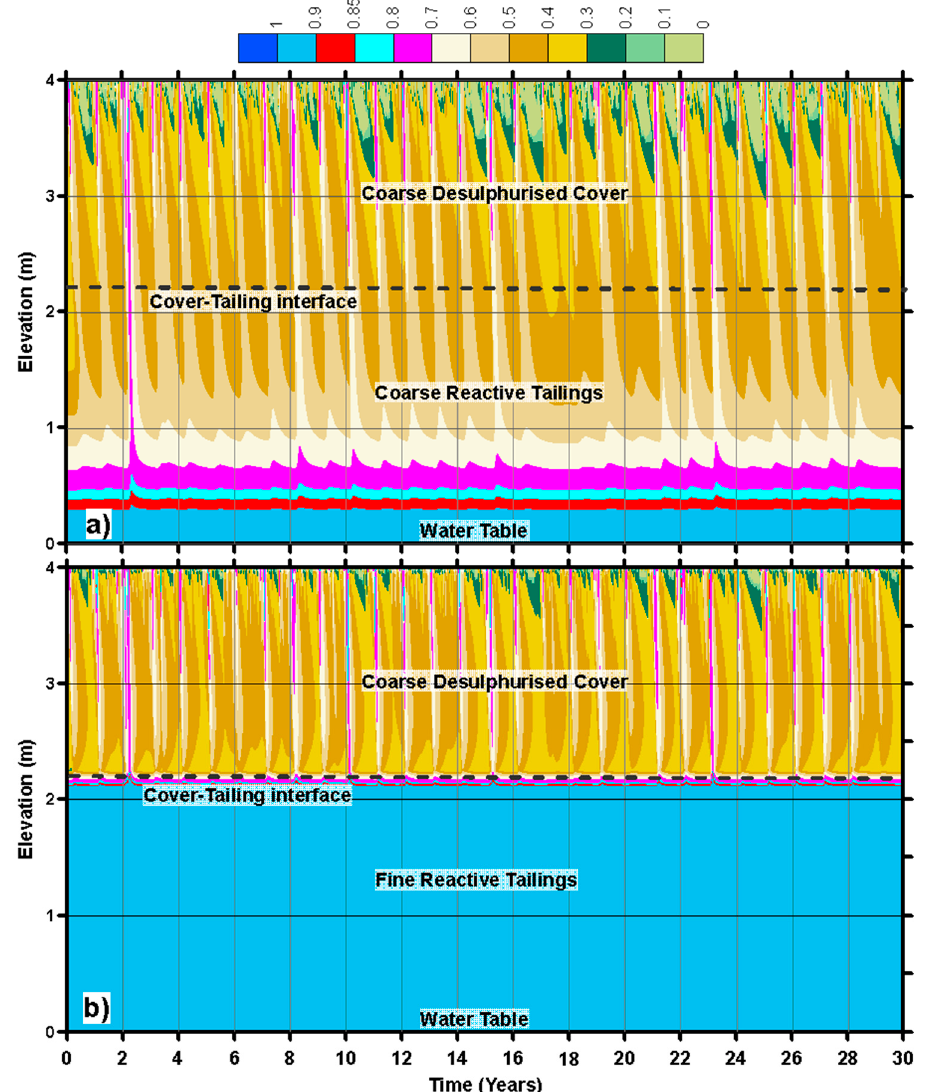
Figure 10. Comparison of 30-year time histories of saturation with depth for ( a ) CC profile, ( b ) CF profile.